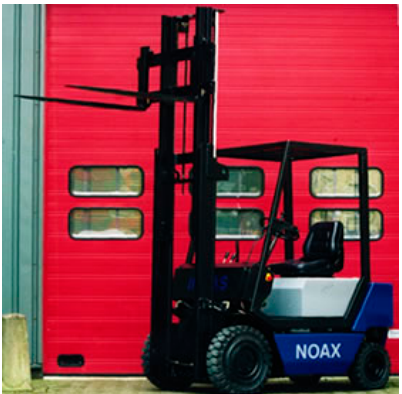
Figure 4. An application of the HFPE in a INNAS forklift [12].